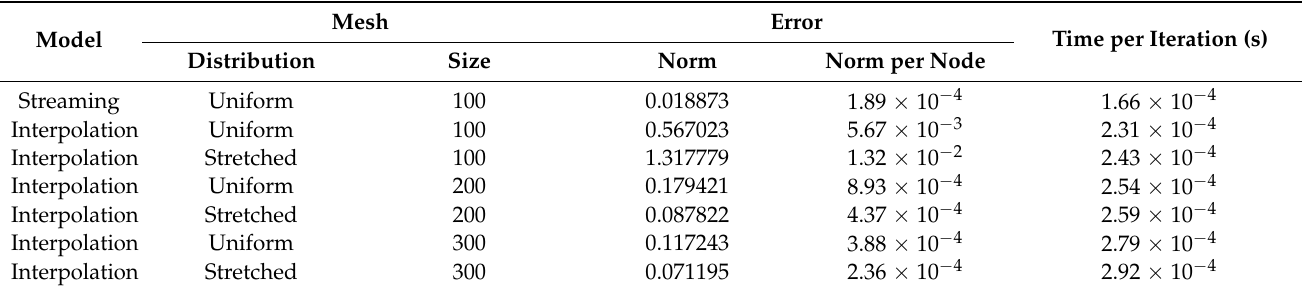
Table 2. Error and computational cost of the advection–diffusion problem.